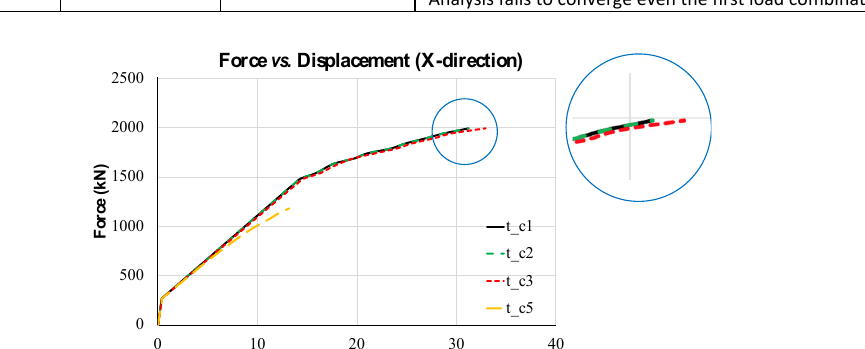
Figure 17. Force vs. displacement influence on cohesion of concrete ‐ concrete contact conditions.